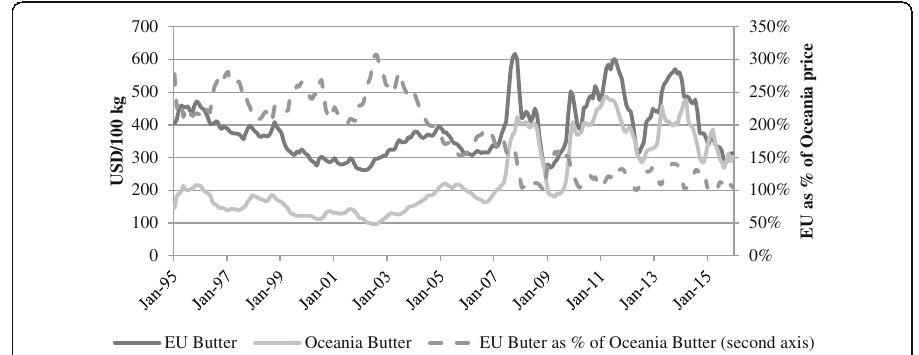
Fig. 9 EU and World butter (primary axis) prices as well as the EU price as a percentage of the